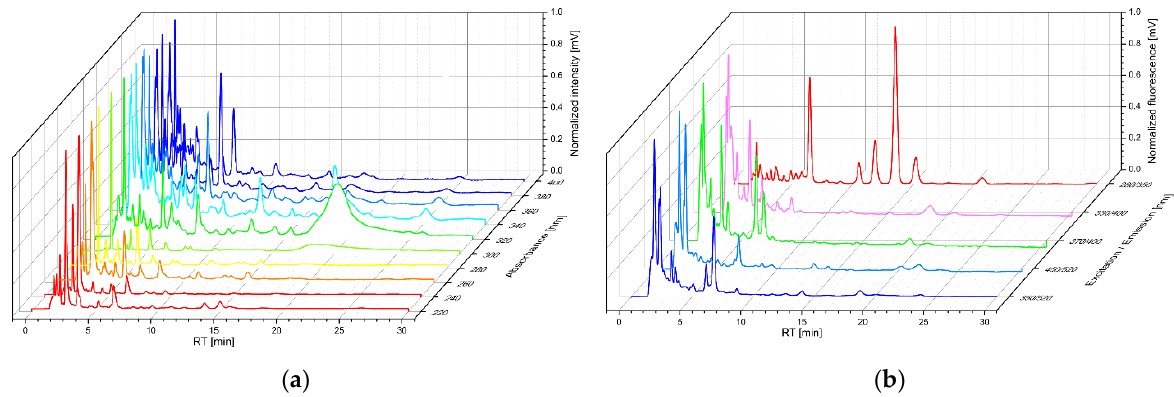
Figure 1. Representative normalized 3D chromatograms of urine for ( a ) absorption detector, ( b ) fluorescence detector; RT —retention time.